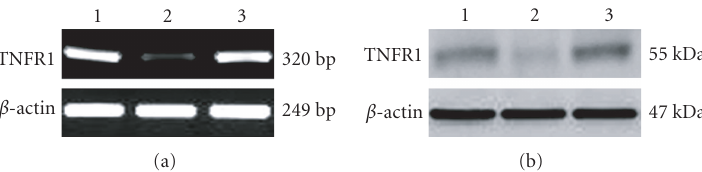
Figure 2: Silencing of TNFR1 in EC109 cells by siRNA. (a) The levels of TNFR1 mRNAs were analyzed by RT-PCR: (1) blank control group; (2) experimental group; (3) negative control group. (b) Expression of TNFR1 was analyzed by Western blot: (1) blank control group; (2) experimental group; (3) negative control group. Results are from one representative experiment from a total of three